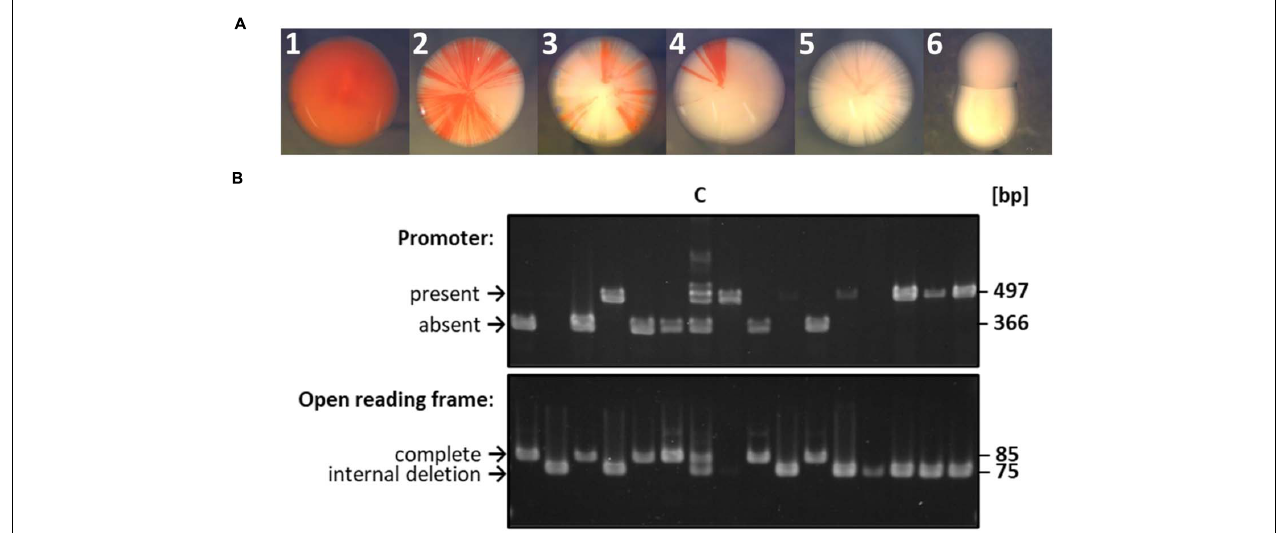
FIGURE 3 | Selected examples of the gene conversion experiment shown in Figure 2 . (A) Selected examples of colonies observed after a gene conversion experiment. The experiment had been performed as schematically shown in Figure 2 . A very early gene conversion event led to colony A, gene conversion events at different times during colony growth led to colonies B to D, and the phenotype of white colonies E and F are not informative about gene conversion. (B) Results of PCR analyses of randomly chosen white colonies. Lane C denotes a control that consisted of an equal mixture of the respective longer version (with promoter, no deletion) and shorter version (without promoter, with ORF-internal deletion). The sizes indicative for the longer version and shorter version are